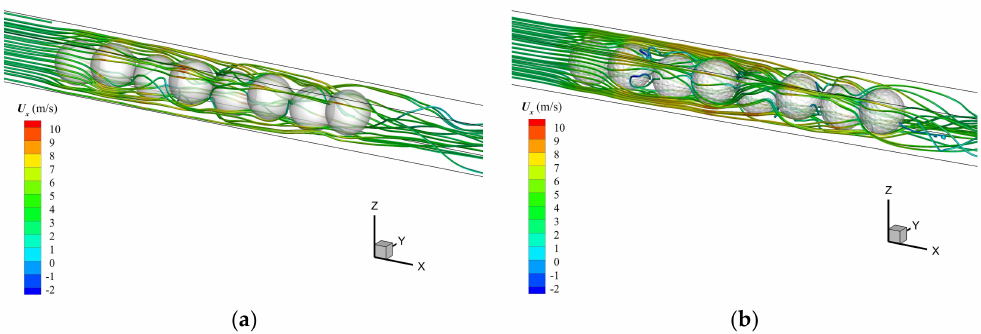
Figure 14. The streamlines of the structured packed bed with smooth or dimpled spheres at N = 1.15 ( Re H = 4599) for ( a ) smooth spheres packed bed and ( b ) dimpled spheres packed